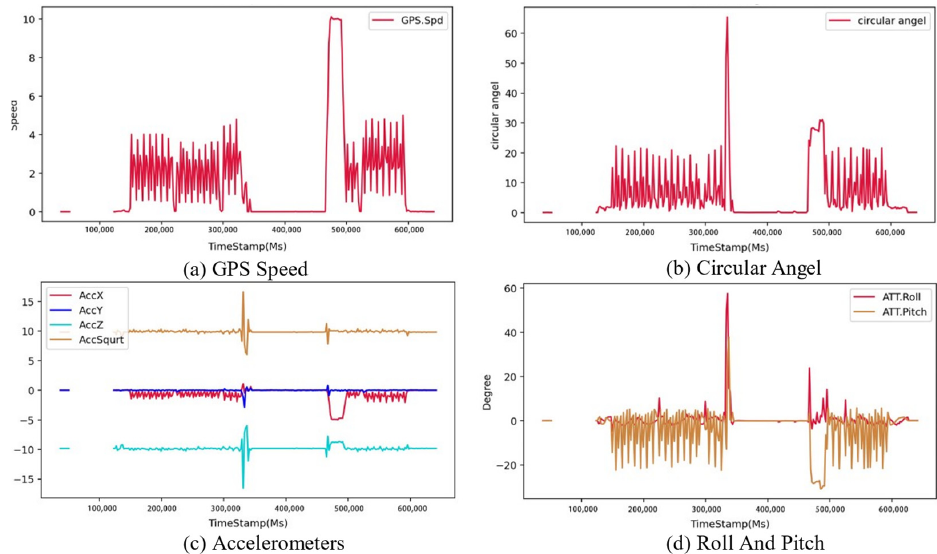
Figure 14. UAV state changes when engine power is lost.